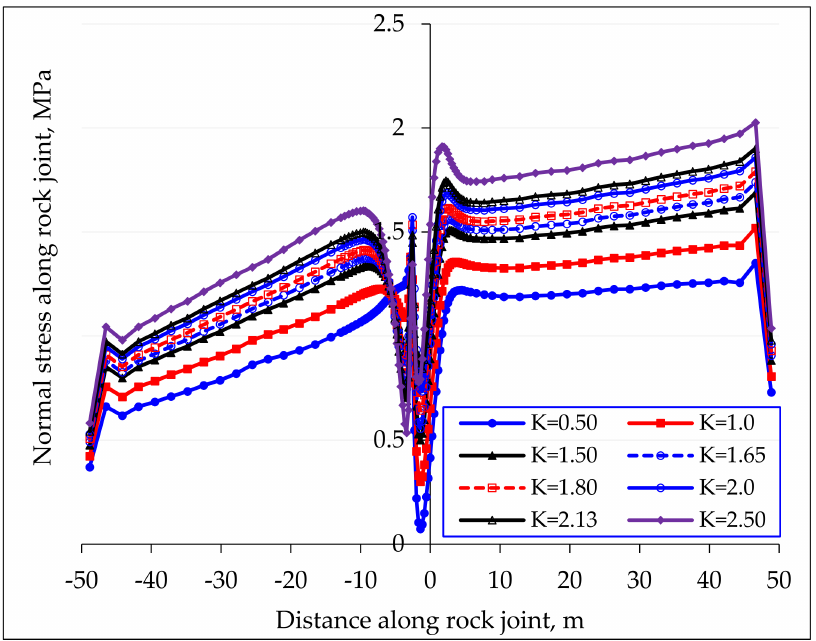
Figure 12. Normal stresses along rock yielded-joint that runs beneath the tunnel opening at various in situ stress ratios